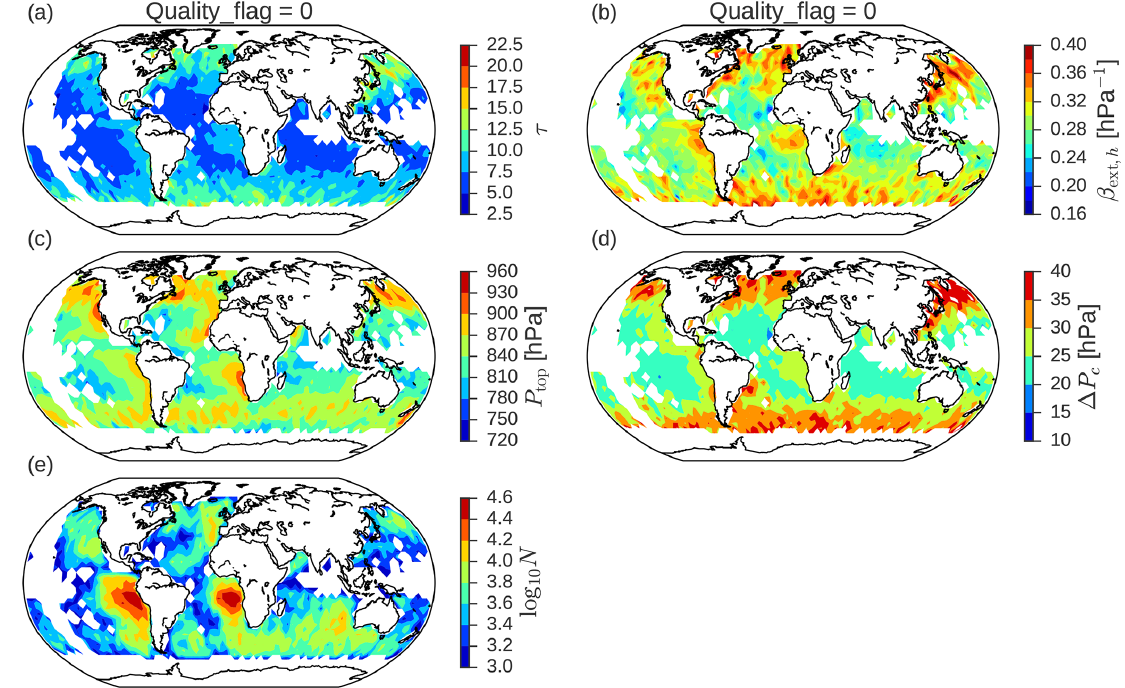
Figure 12. Mean retrieved properties over full OCO2CLD-LIDAR-AUX record on a 4 ◦ × 4 ◦ latitude–longitude grid; only Quality_flag = 0 retrievals are included. (a) Cloud optical depth. (b) Homogeneous cloud extinction coefficient β ext , h = τ/(cid:49)P c . (c) Cloud top pressure. (d) Cloud pressure thickness. (e) Logarithm of retrieval count.